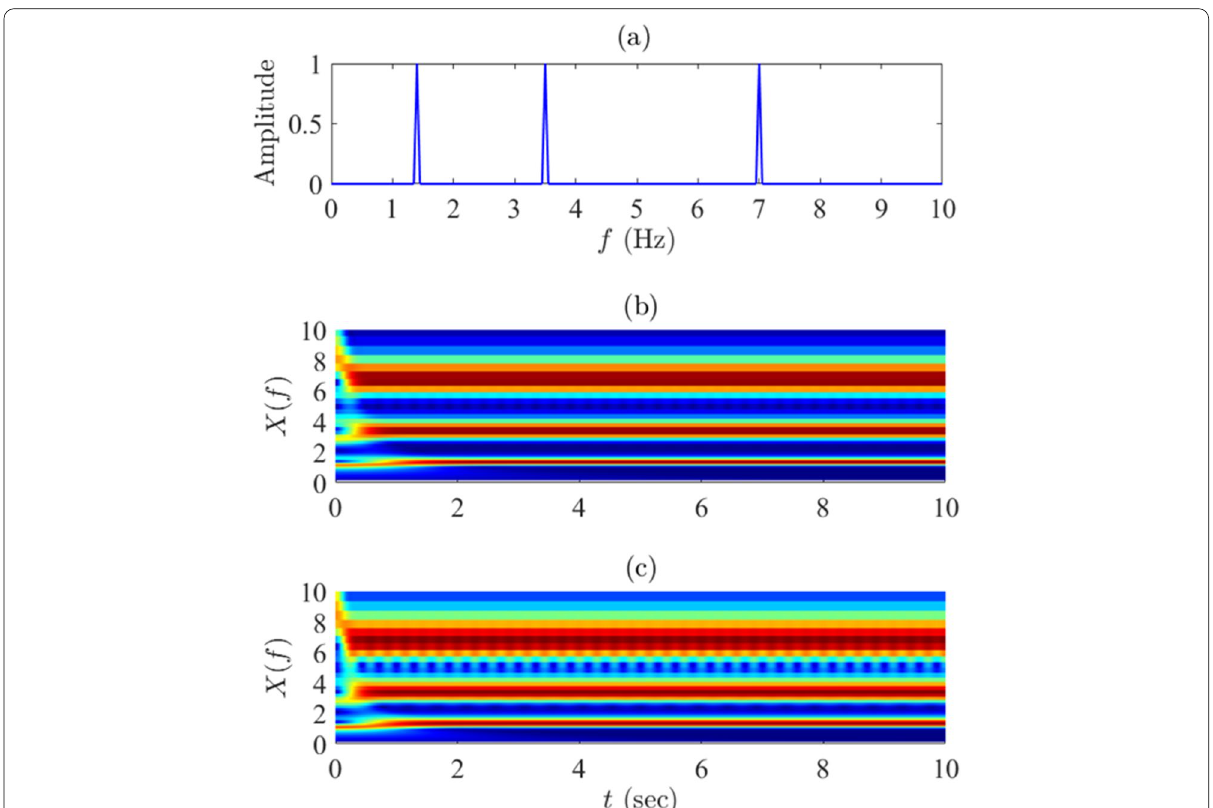
Fig. 1 ( a ) Fourier spectrum of the mixed-signal and ( b ) and ( c ) its spectrogram obtained from the CWT using Morse and Morlet basis functions,